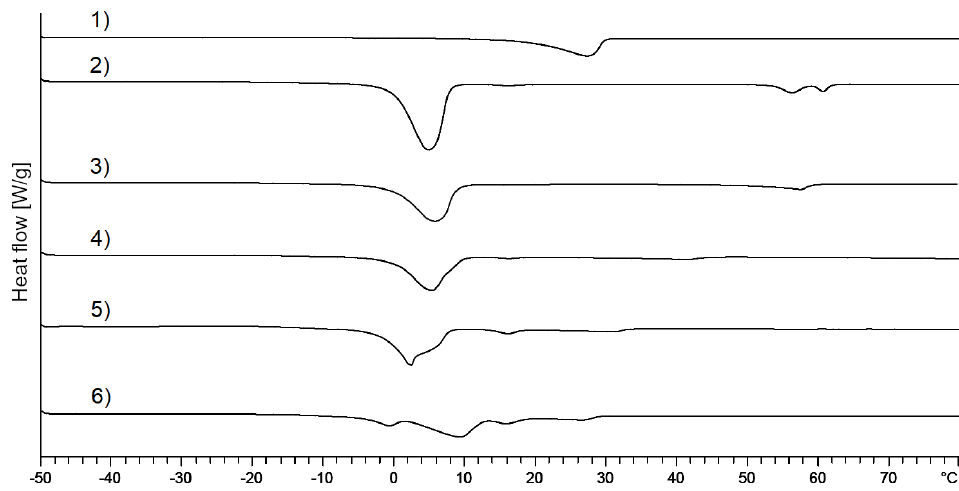
Figure 11. DSC thermograms of (1) 1,2-octanediol; (2) mixed crystal without alkanediols; (3) mixed